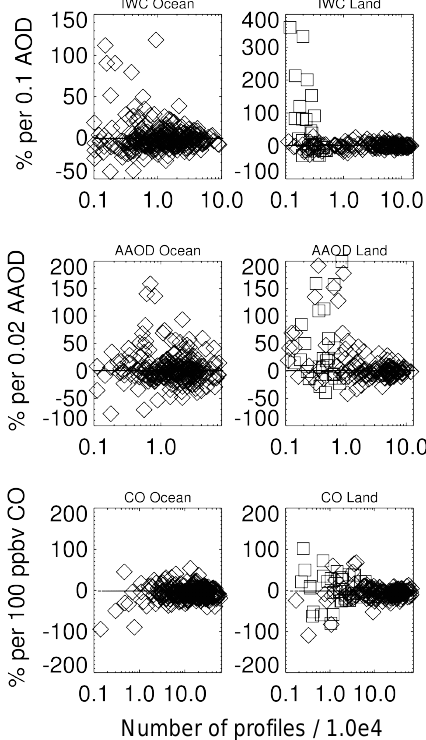
Number of profiles / 1.0e4 Figure 7. Statistical distribution of IWCreg derivatives between 5 and 15km altitude for individual regions and seasons as a function of the number of profiles used to define each derivative. Derivatives over mainland India are assigned a square symbol. Table 2. Average IWCreg derivatives over ocean and land (in %/0.1 AOD units) expressed as a function of average pixel-distance values used to derive the AOD fields. Numbers in parenthesis are the numbers of derivatives used to define each average IWCreg deriva-